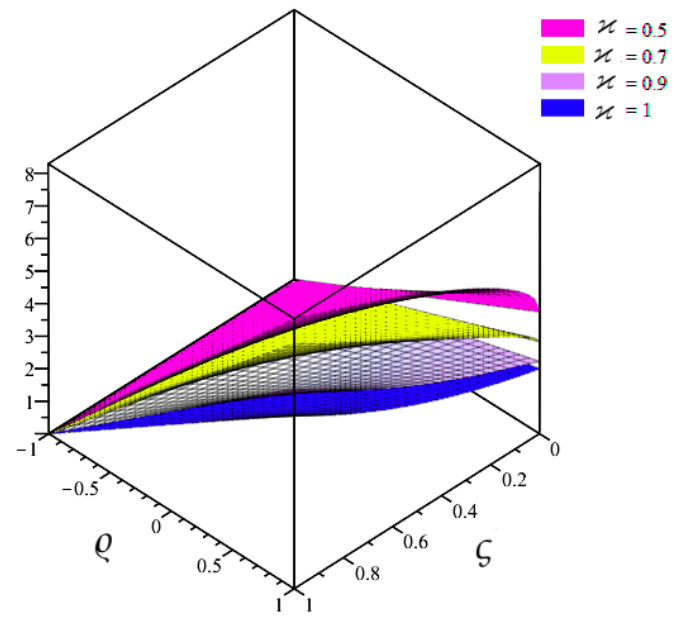
Figure 2. The three dimensional various fractional order graph of κ . Table 1. Absolute error of Exact and fourth terms approximate solutions for Problem 1 with various ς and (cid:36) for κ =